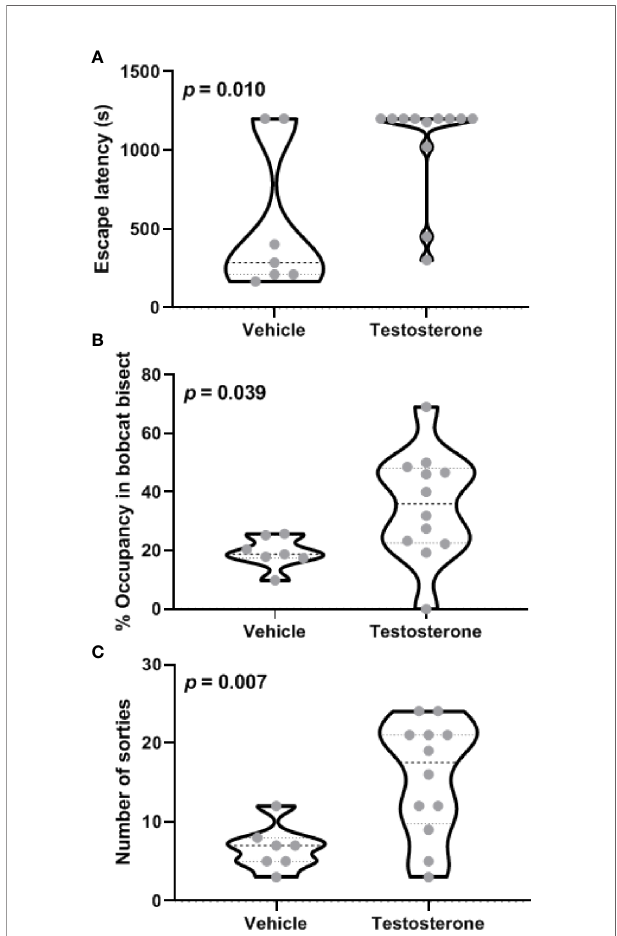
FIGURE 1 | Effects of testosterone supplementation within the posterodorsal medial amygdala on defensive behavior. Latency to escape from the testing arena (A) , relative occupancy in bisect of the arena containing bobcat urine (B) , and total number of sorties made during the trial (C) are depicted. Violin plots in these panels depict median and inter-quartile range along with raw values for all data points (n = 7 animals for vehicle and 11 for the testosterone-treated group). The p -values for inter-group differences are depicted in each